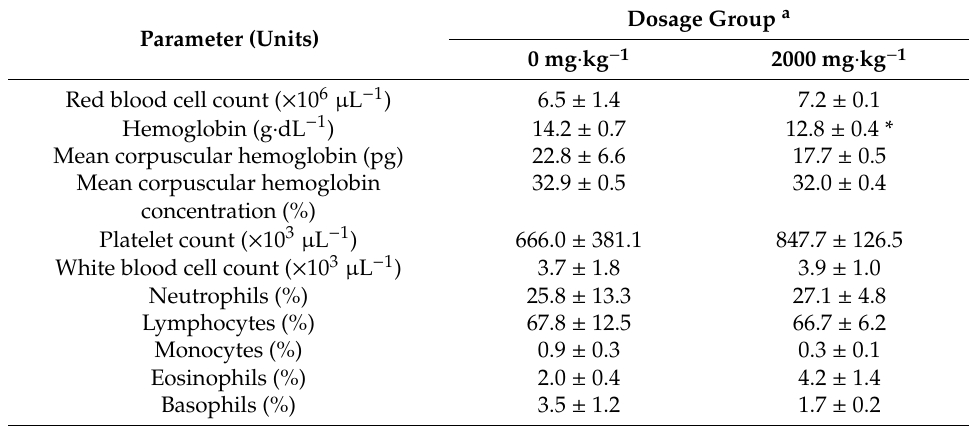
Table4. Hematologic values forfemale rats after 14 days of beingexposed to a single dose (2000 mg · kg − 1 ) of a food-grade extract from avocado seed (Avosafe ® ), with an acetogenin purity of Table 4. Hematologic values for female rats after 14 days of being exposed to a single dose (2000